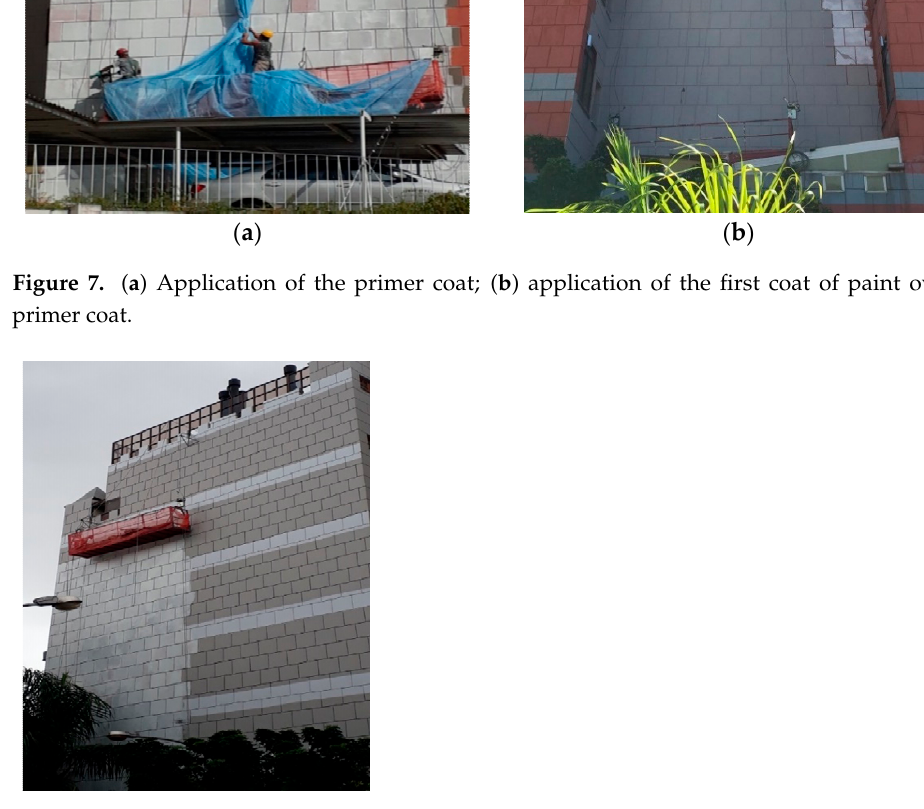
Figure 7. ( a ) Application of the primer coat; ( b ) application of the first coat of paint over the primer coat.